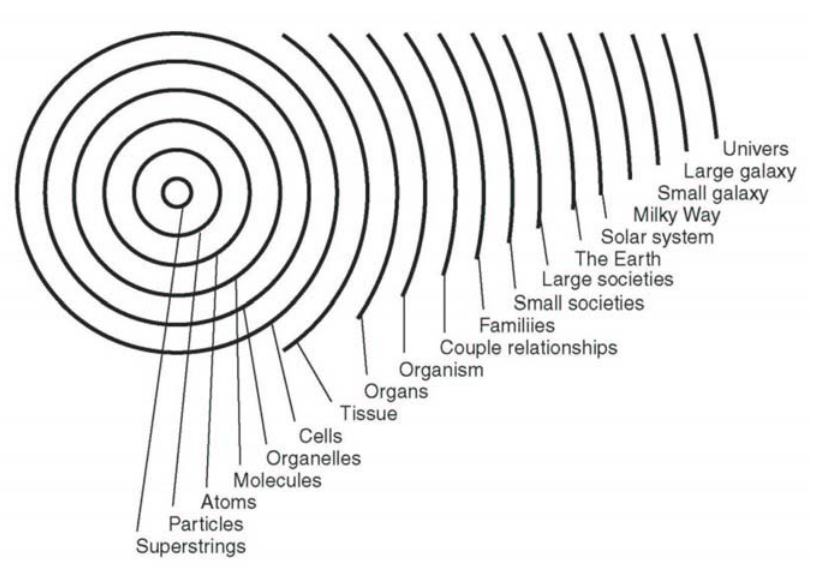
FIGURE 1. How reason has divided reality into scientific disciplines according to the size of the objects of